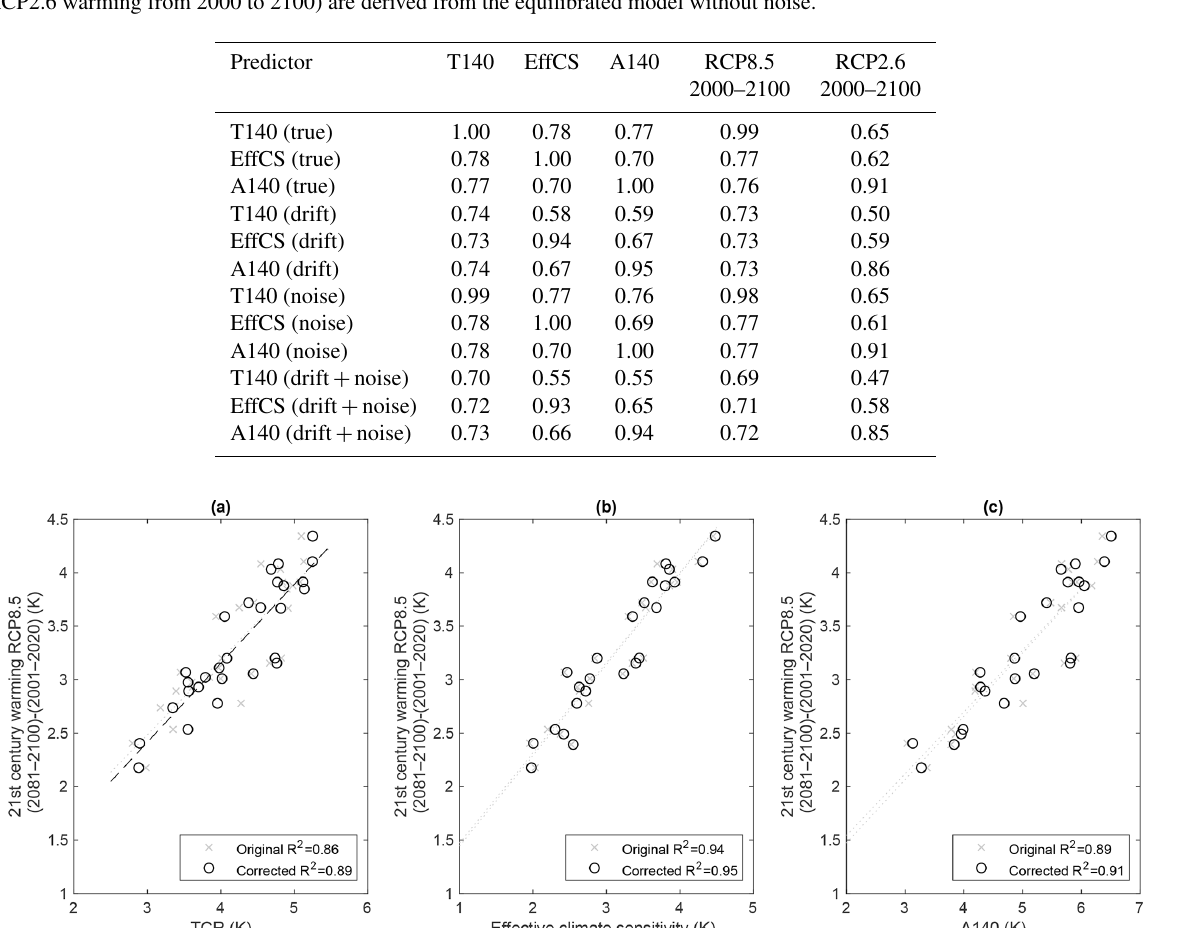
Figure 6. Plots showing the correlation between TCR (a) , EffCS (b) and A140 (c) with 21st century warming, here represented by the difference between 2001–2020 and 2081–2100 global mean temperatures in the first ensemble member for each model in the CMIP5 archive for the RCP8.5 scenario. Each plot shows the “original” calculation, where the baseline temperatures (and TOA fluxes for EffCS) are taken as the piControl mean. In the “corrected” calculation, a correction term for the baseline temperature and control drift is applied. Correlation coefficients are shown for the original and corrected